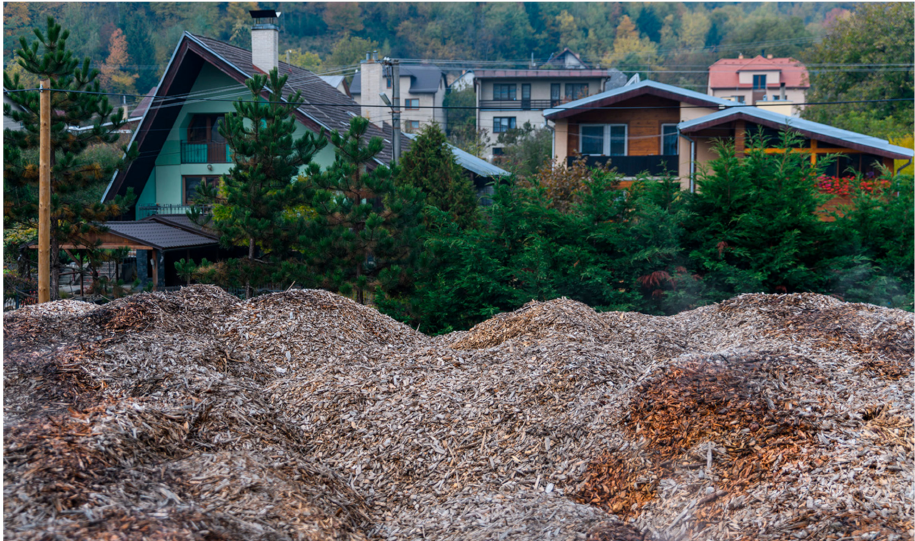
Figure 1. Storage 1 and biomass storage distance from civil buildings.